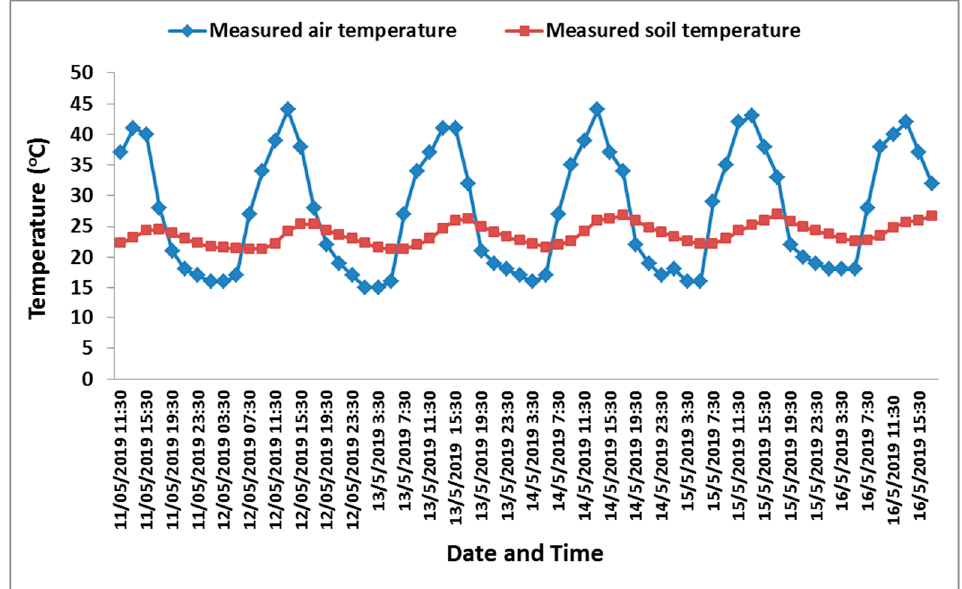
Figure 7. Air and soil temperature (°C) recorded by the designed automated monitoring system.